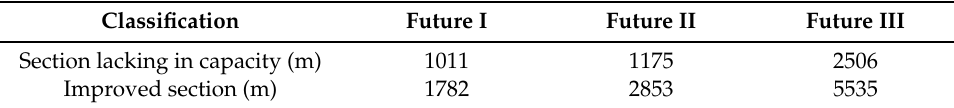
Table 4. Changes in capacity for inadequate sections in the target area.